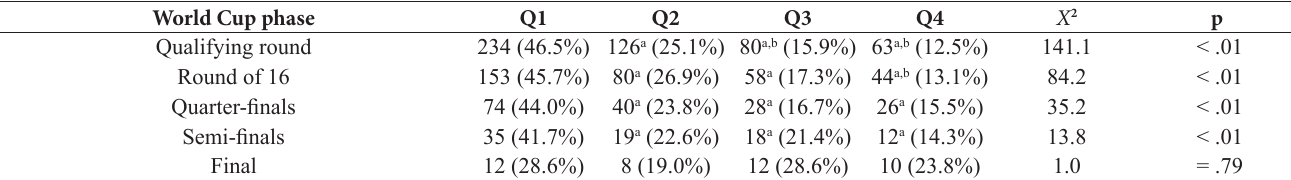
Table 1. Number of players selected by coaches who born in each of the four quarters of the year according to each tournament phase ( n ; %). World Cup